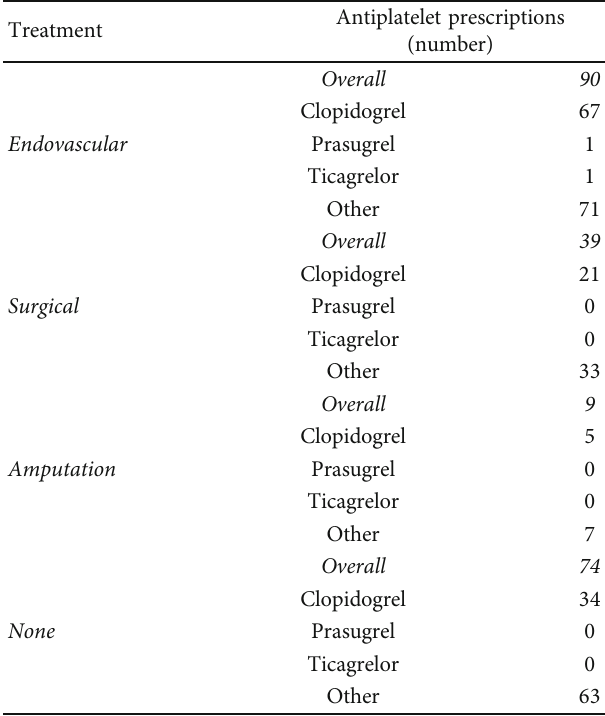
Table 2: Antiplatelet therapy prescribed within 90 days, strati fi ed by primary treatment